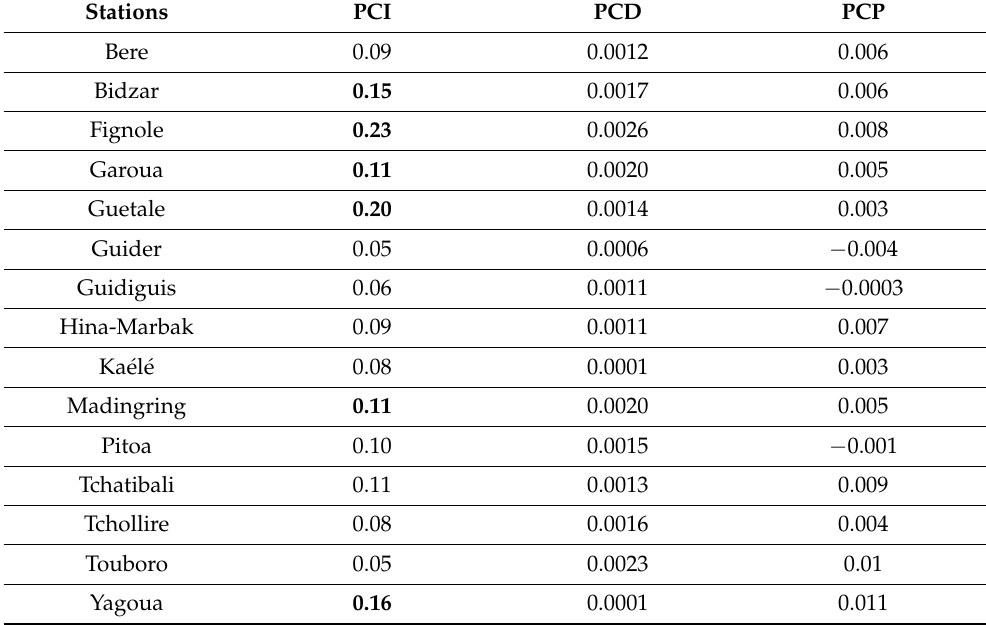
Table 4. Innovative trend analysis (ITA) slopes for PCI, PCD, and PCP. Significant changes (i.e., at the 90% level) are indicated in